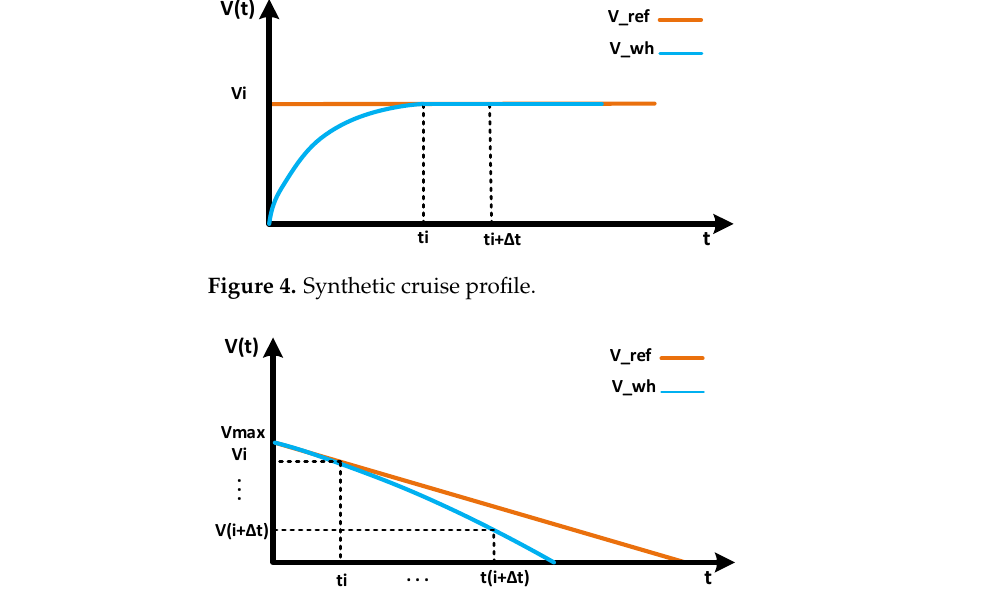
Figure 5. Synthetic deceleration profile.